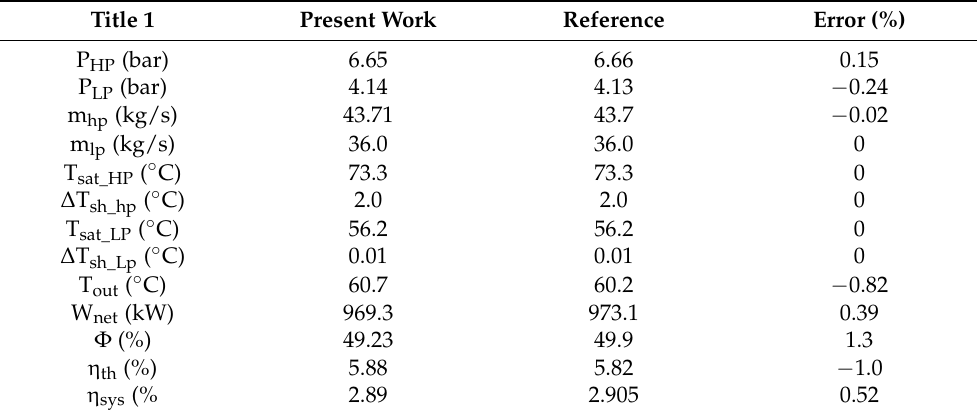
Table 6. Validation of dual pressure ORC systems model.